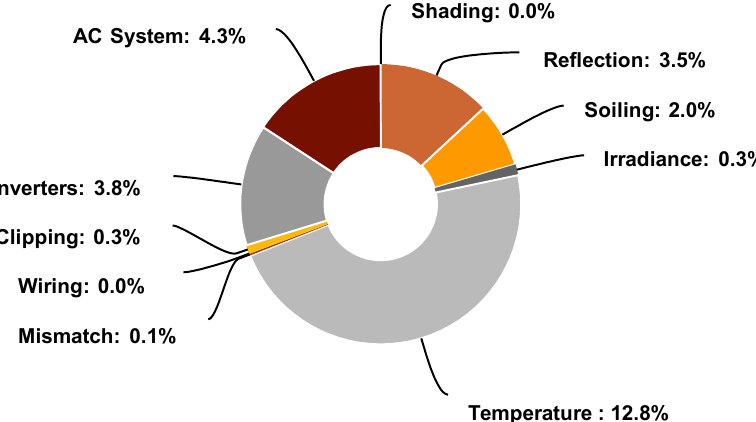
Figure 13. Canal-top PV loss via GIS investigation obtained through Helioscope simulations.